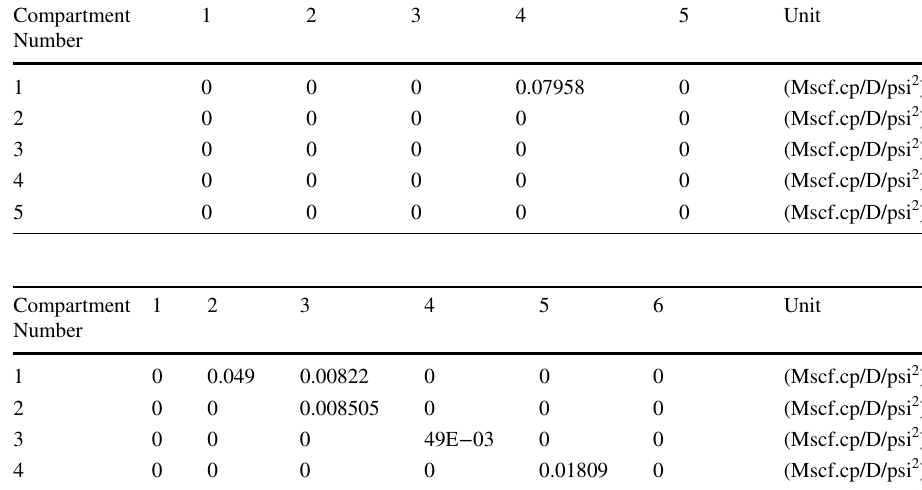
parameters for layer 2 in field case 2